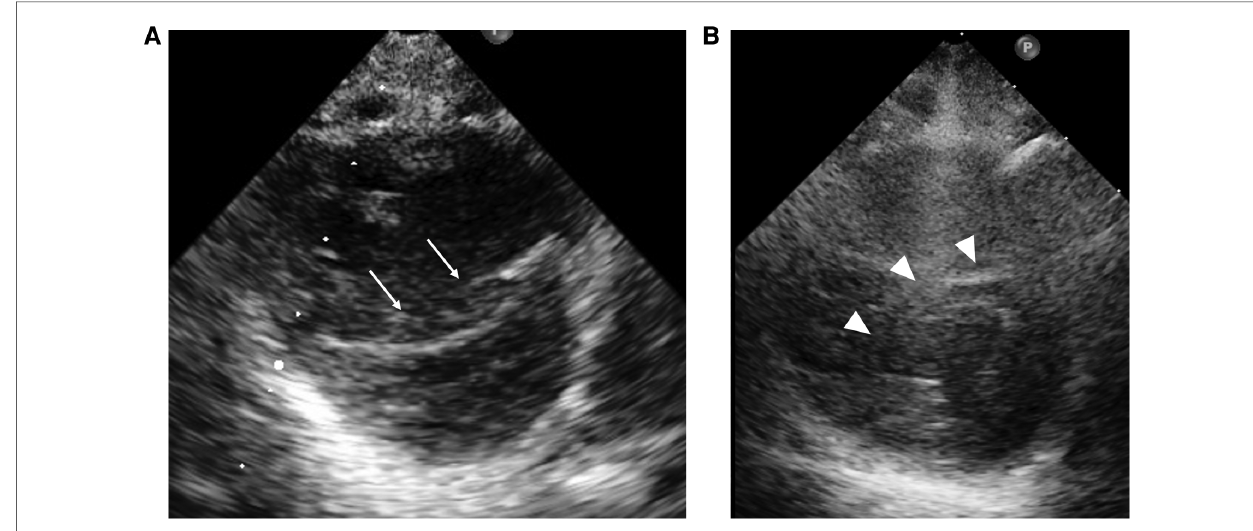
FIGURE 4 Case 2: echocardiography in the parasternal short-axis view. Echocardiography at the beginning of epoprostenol infusion ( A ) shows that the inverted interventricular septum (white arrow) compresses the left ventricle. At the time of epoprostenol infusion above 100 ng/kg/min ( B ), the interventricular septal shift (white arrowhead) and LV compression